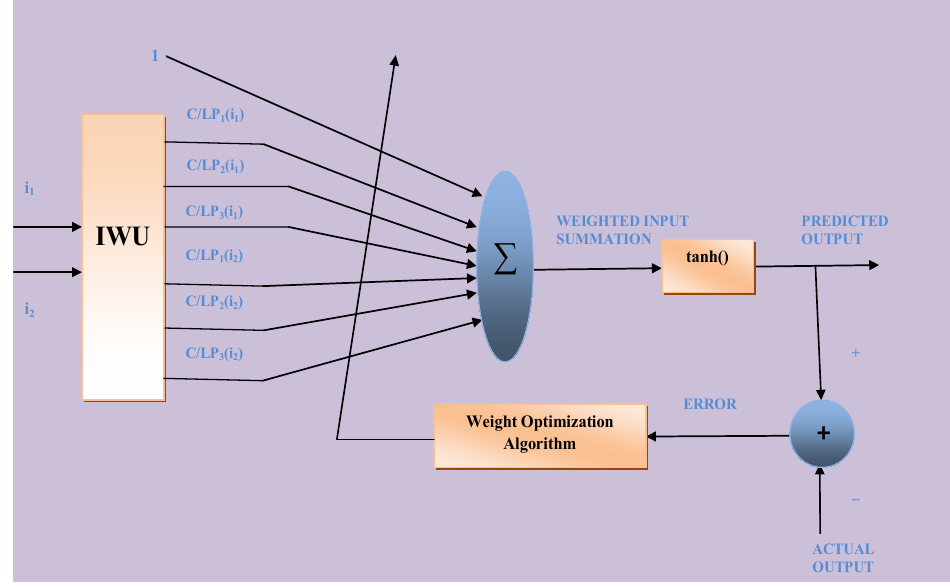
Figure 1. Architecture of Polynomial Based Neural Network.